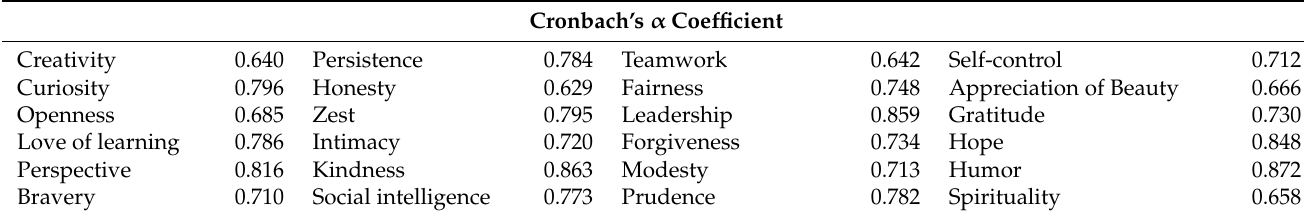
Table 3. Internal Consistency Coefficients for the Character Strengths ( n =